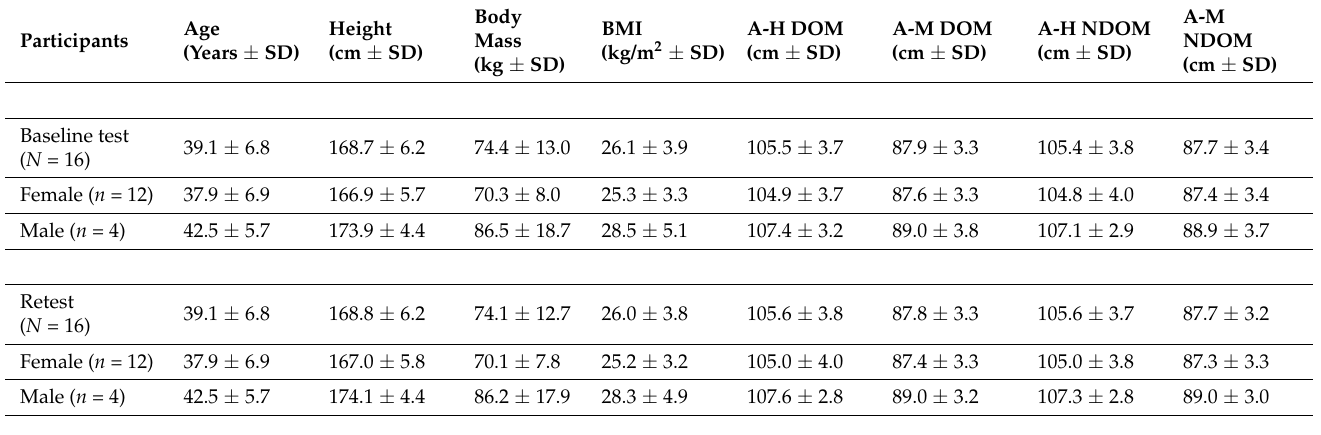
Table 2. Mean calculated scores for reaching directions, effect sizes, ICC values, SEM percentages, and MDC scores.